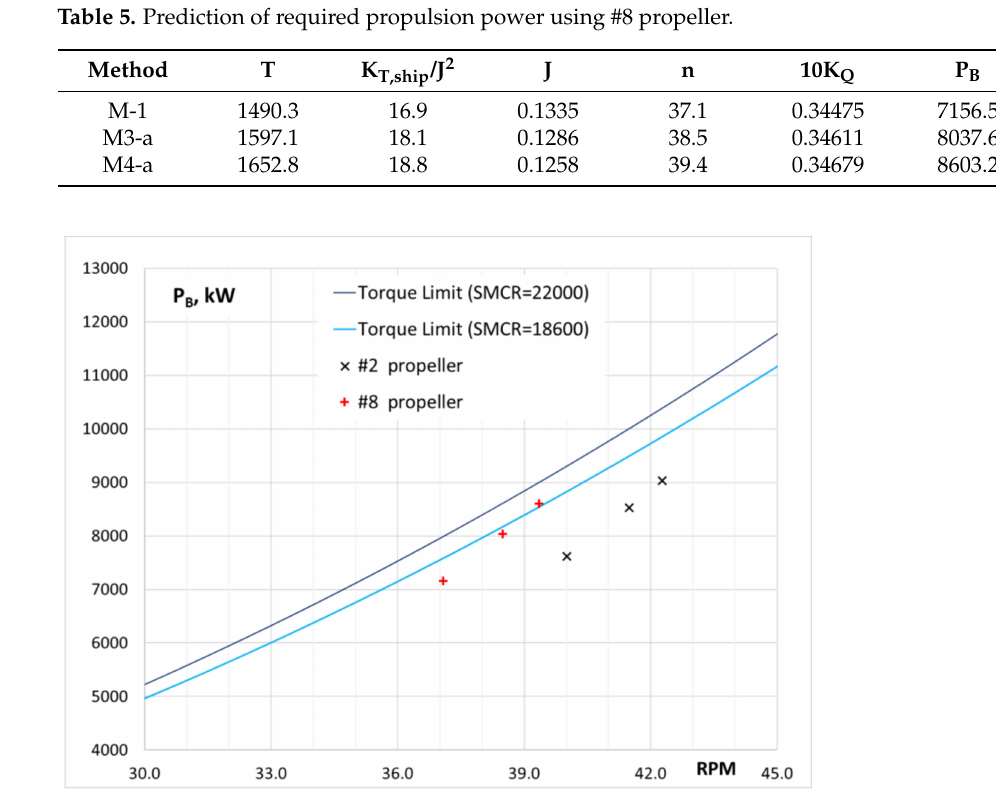
Figure 8. The operating points in adverse conditions predicted using alternative methods, shown in the engine load